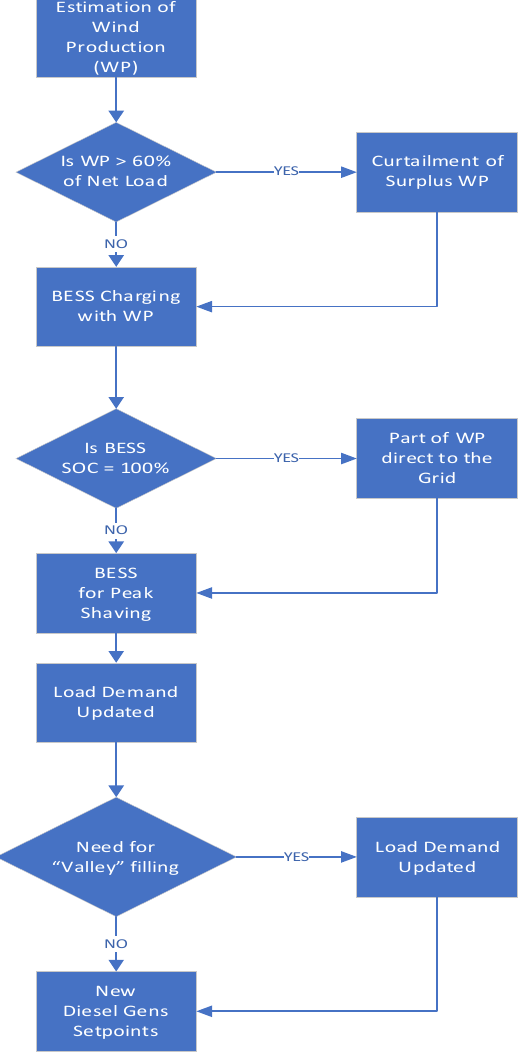
Figure 4. Flowchart of Astypalaia non-interconnected insular power system (NIIS) operation considering hybrid power plant (HPP) installation.